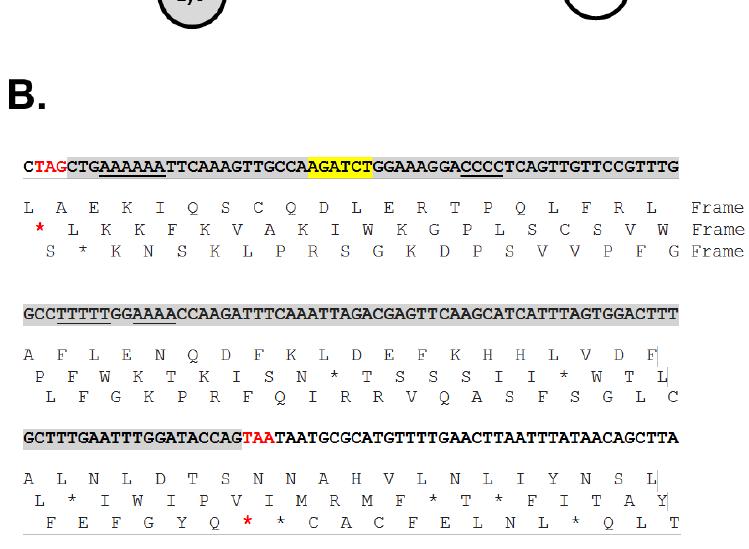
FIGURE 1: LYS2 -based frameshift re- version assays. (A) Cartoon illustrating how stop codons in alternative reading frames define a reversion window (blue). The horizontal arrow indicates the direction of transcription and as- terisks correspond to frameshift muta- tions. A stop codon encountered dur- ing translation is red; a gray stop co- don is in a different reading frame and does not affect translation. (B) Se- quence of the region of the LYS2 ORF that contains the lys2∆Bgl reversion window (gray), which is delimited by the boxed stop codons. Mononucleo- tide runs >3N are underlined and the Bgl II site is highlighted